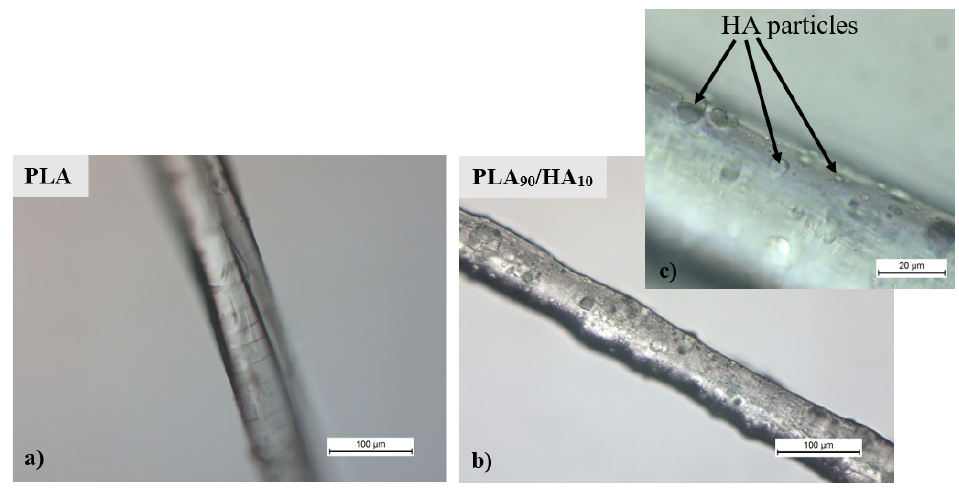
Figure 5. OM pictures of microfilaments of ( a ) a pure PLA filament and ( b ) a PLA 90 /HA 10 filament, and ( c ) close up on a PLA 90 /HA 10 filament.